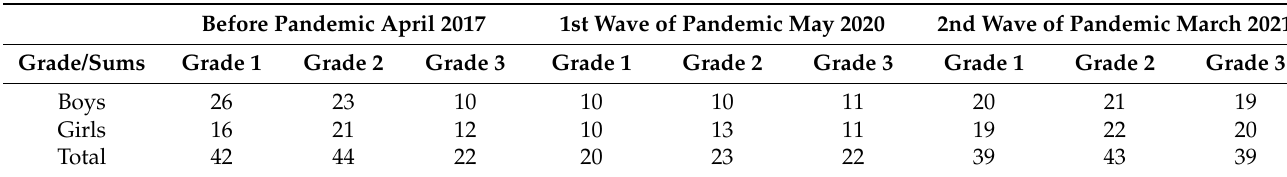
Table 1. Research